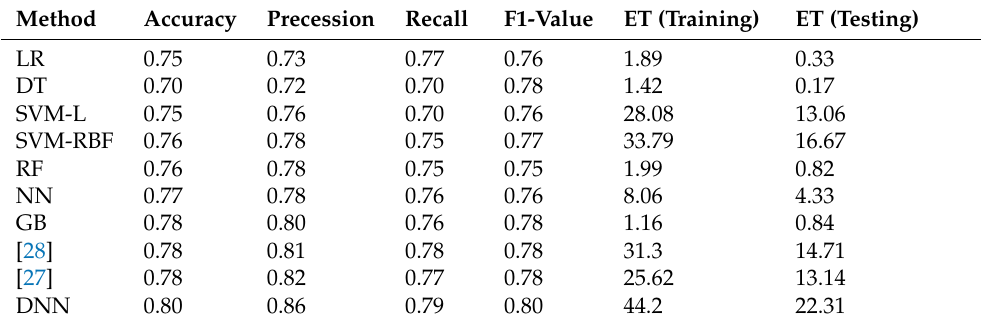
Table 2. Comparative analysis of ML algorithms in terms of accuracy, precision, recall, F1 score, and execution time